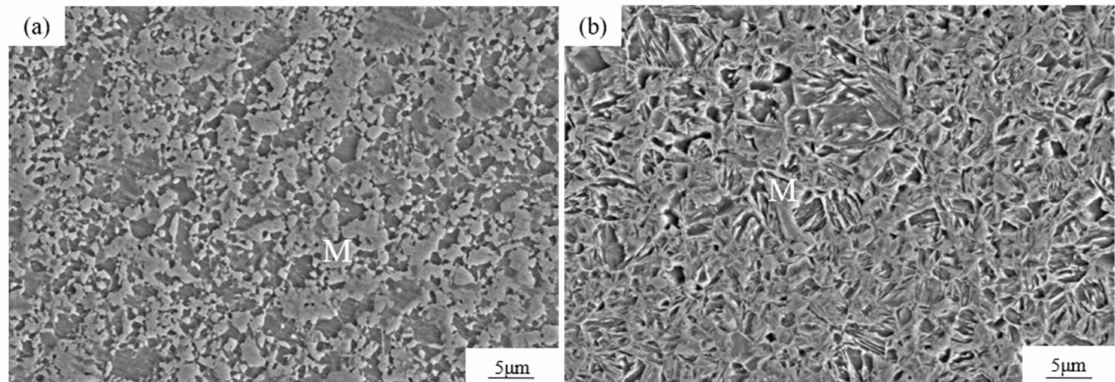
Figure 12. Microstructures of steel A ( a ) and B ( b ) under flash heating to 880 ◦ C then air cooled.